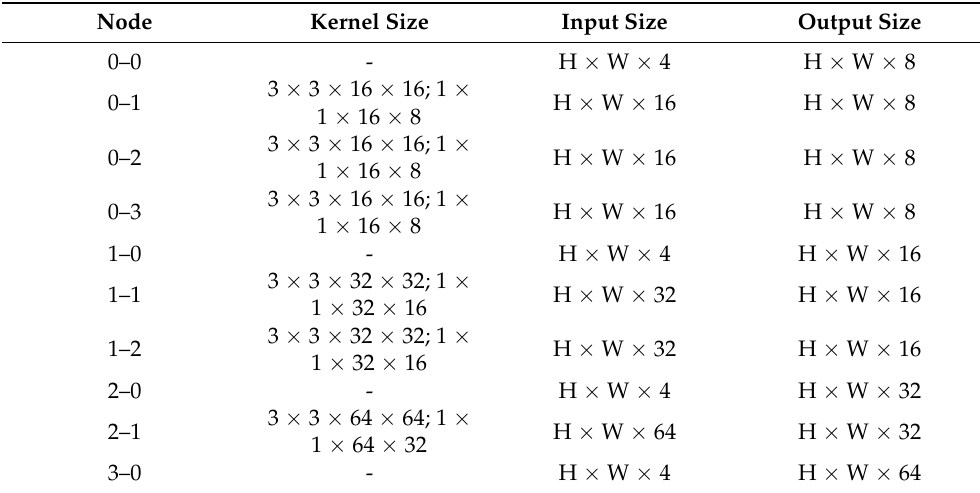
Table 2. Network details of each node in Figure 2, including the convolutional kernel size of the reconstruction nodes, the input size, and the output size of feature maps. Node Kernel Size Input Size Output